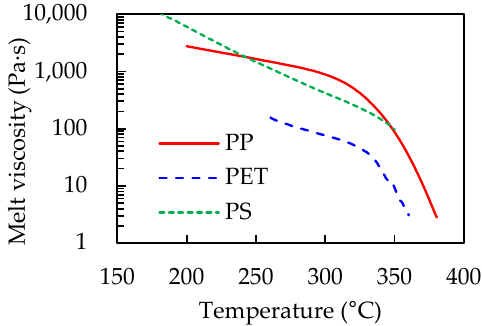
Figure 3. Temperature dependence of melt viscosity of PP, PET, and PS.